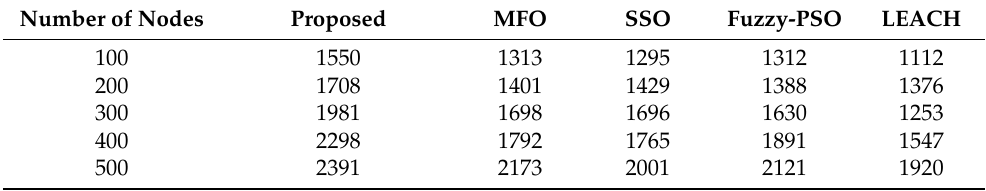
Figure 8. Analysis of network life-time vs. number of nodes. Table 8. Network lifetime comparison with different routing